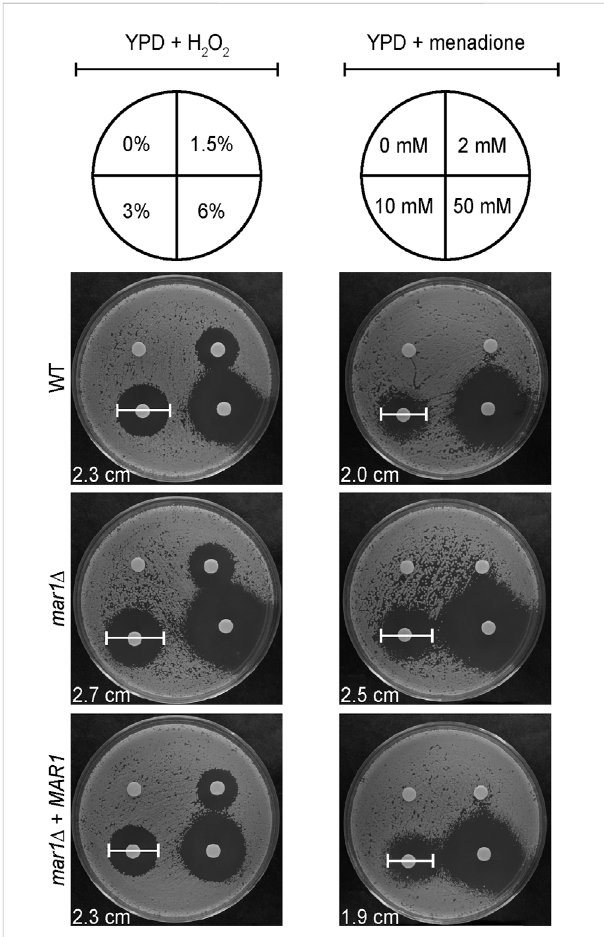
FIGURE 6 Mar1 contributions to growth in the presence of oxidative stress. A. Susceptibilities of the WT strain, the mar1 Δ mutant strain, and the mar1 Δ + MAR1 complementedstraintohydrogenperoxide(H menadione were assessed. Strains were normalized by OD 600 and were subsequently grown on YPD medium agar plates spotted with differing concentrations of H 2 O 2 (left) and menadione (right). Solvents alone were used as controls. Plates were incubated at 30 ° C and imaged daily. Zones of clearance were measured and used as indicators ofsusceptibility. Included zoneofclearance measurements are from 3% H 2 O 2 and 10 mM menadione. Experiment was repeated two times to ensure reproducibility and representative images are